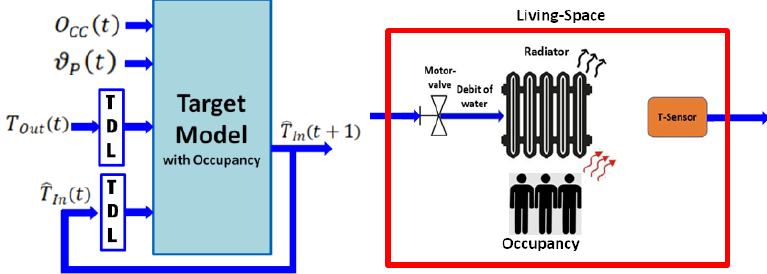
Figure 2. Proposed identification architecture of the target heating model (left-side) and general diagram of the modeled living space including the influence of its occupancy (right-side).